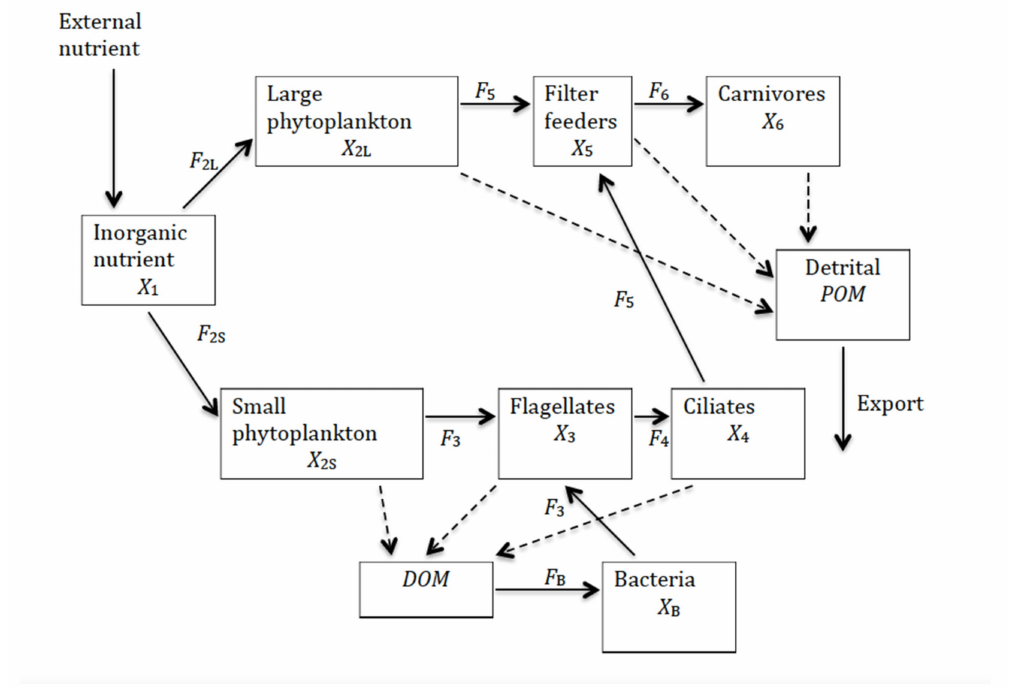
Figure 1. Schematic of the food web model. Solid lines indicate grazing; dashed lines indicate excretion of either dissolved organic matter (DOM) or particulate organic matter